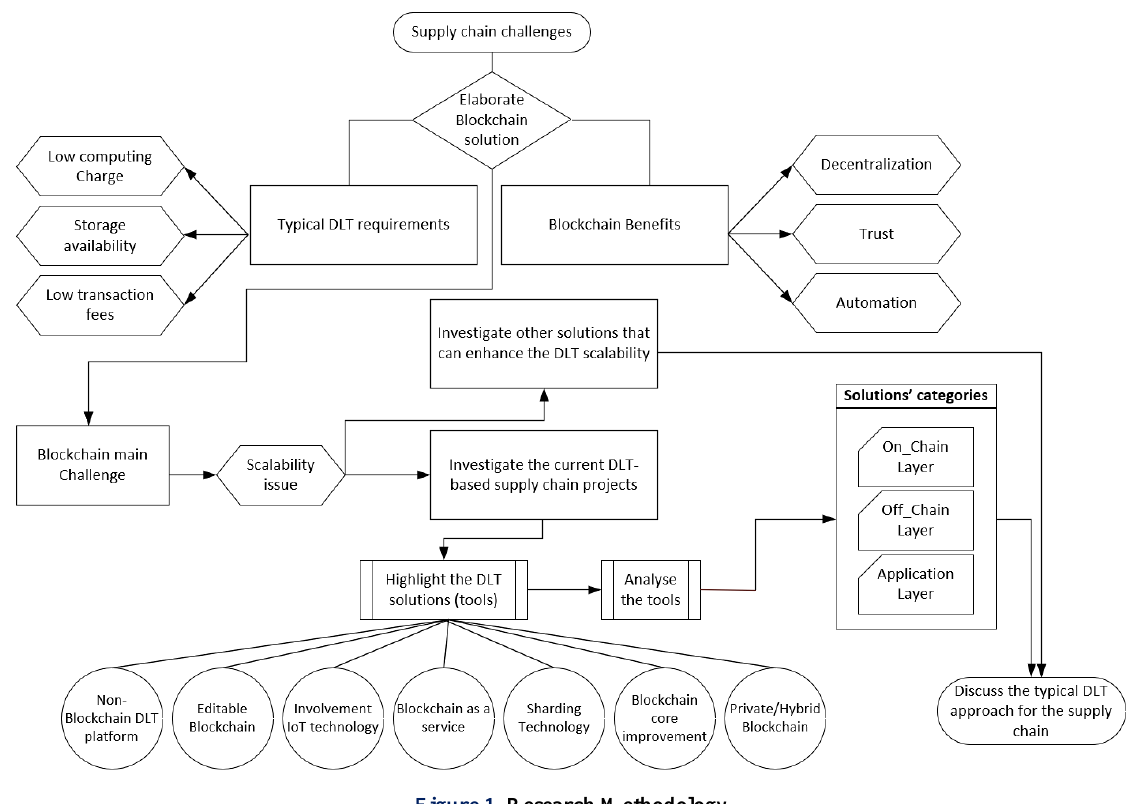
Figure 1. Research Methodology.